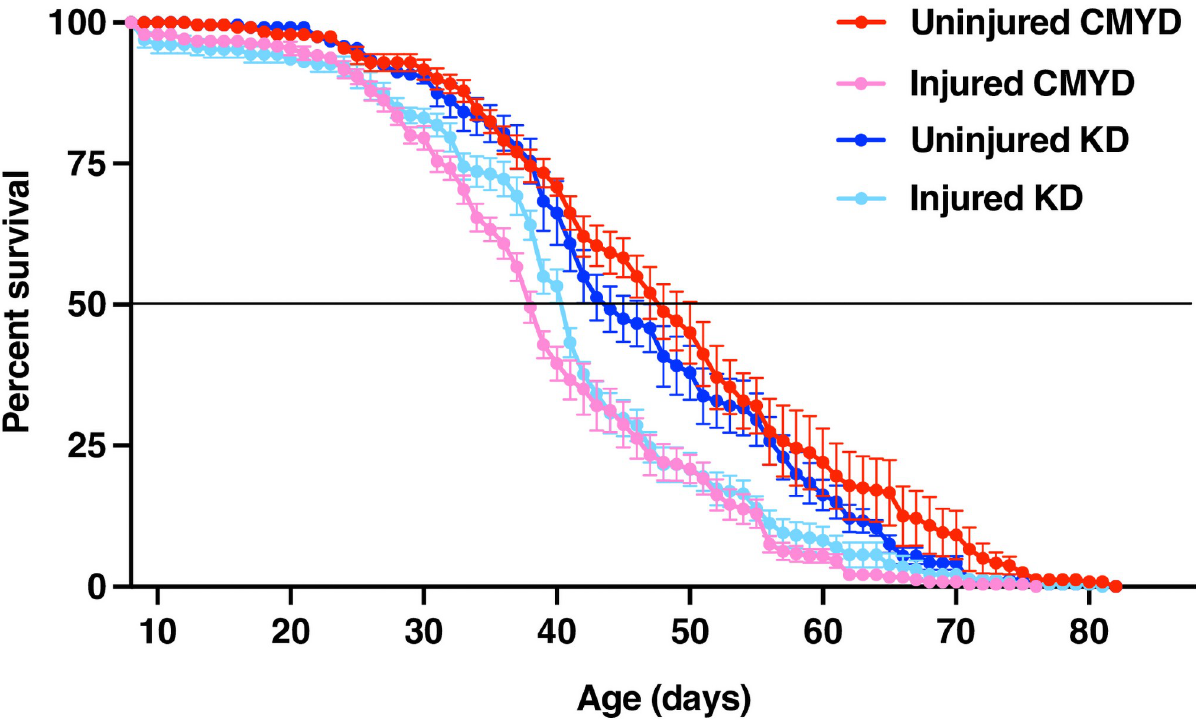
Fig 3. KD has a long-term beneficial effect on lifespan following TBI. Percent survival was determined for uninjured and injured 0–7 day old, mixed sex w 1118 flies fed 0.3 cal/200 μ l CMYD or KD for 24 h following TBI and solid CMYD thereafter, that is, flies in the experiment that survived 24 h feeding on 0.3 cal/200 μ l CMYD or KD were fed solid CMYD throughout the rest of their lifespan. At least 230 flies were examined for each condition. Error bars indicate the SEM, and the horizontal line at 50% indicates the median lifespan.